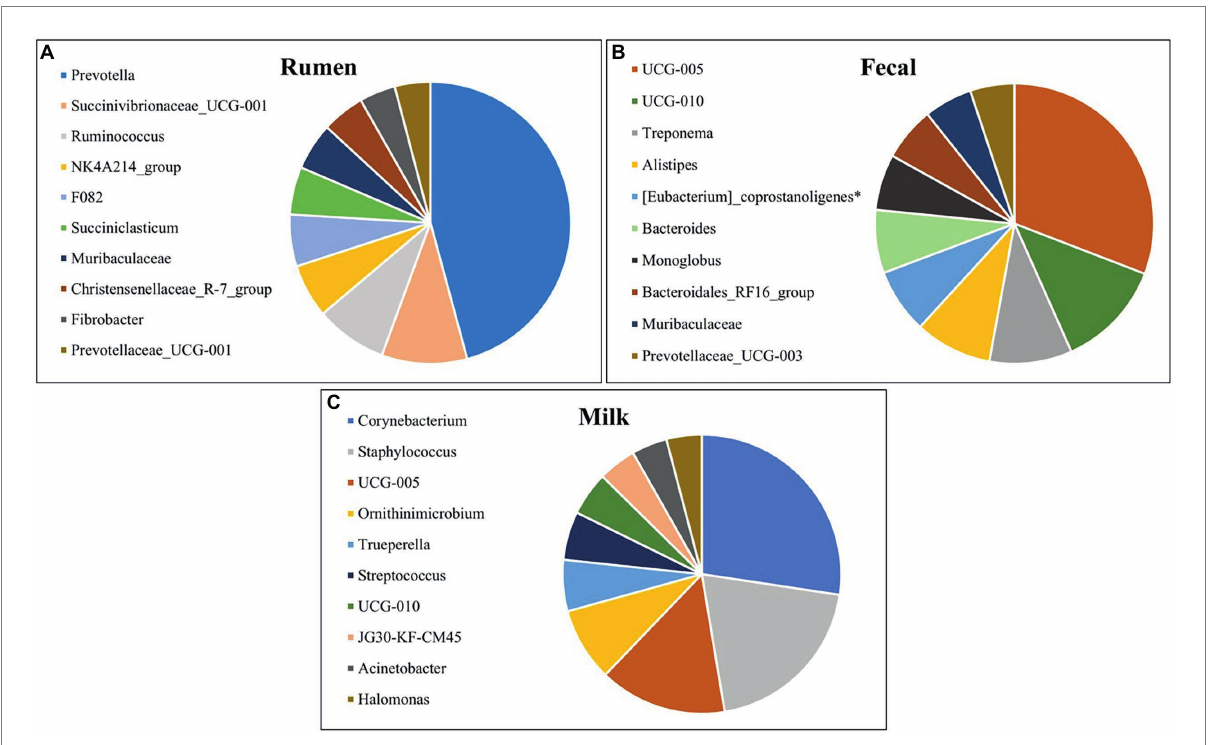
FIGURE 5 Top 10 most abundant bacterial genera detected in the (A) rumen ( n = 51), (B) fecal ( n = 51) and (C) milk ( n = 47) samples of Holstein dairy cattle.